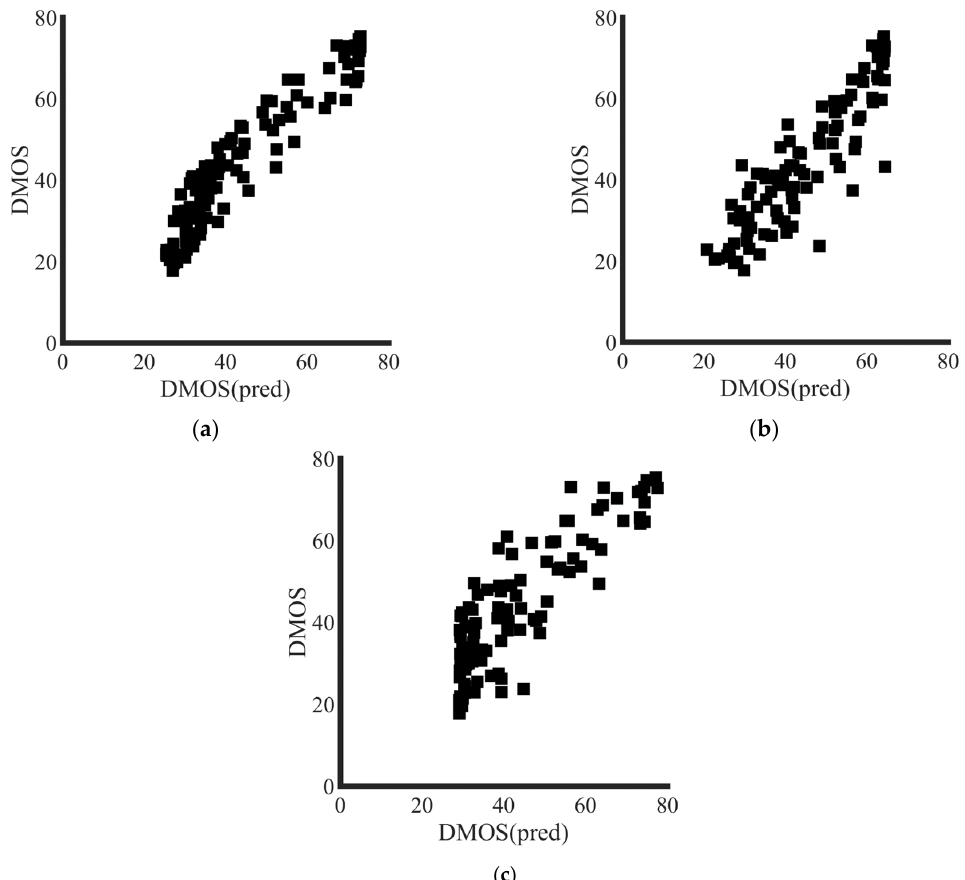
Figure 22. The relationship between predicted subjective evaluation values and subjective evaluation values: ( a ) proposed method; ( b ) reference [14] method; ( c ) tenegrad method.